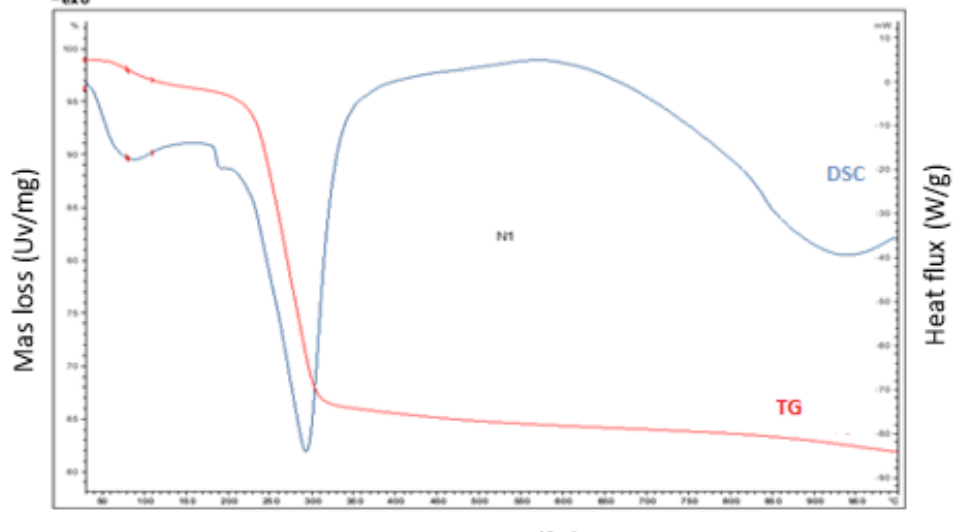
Figure 7. DSC/TGA curves of the HAp/HPMC composite.